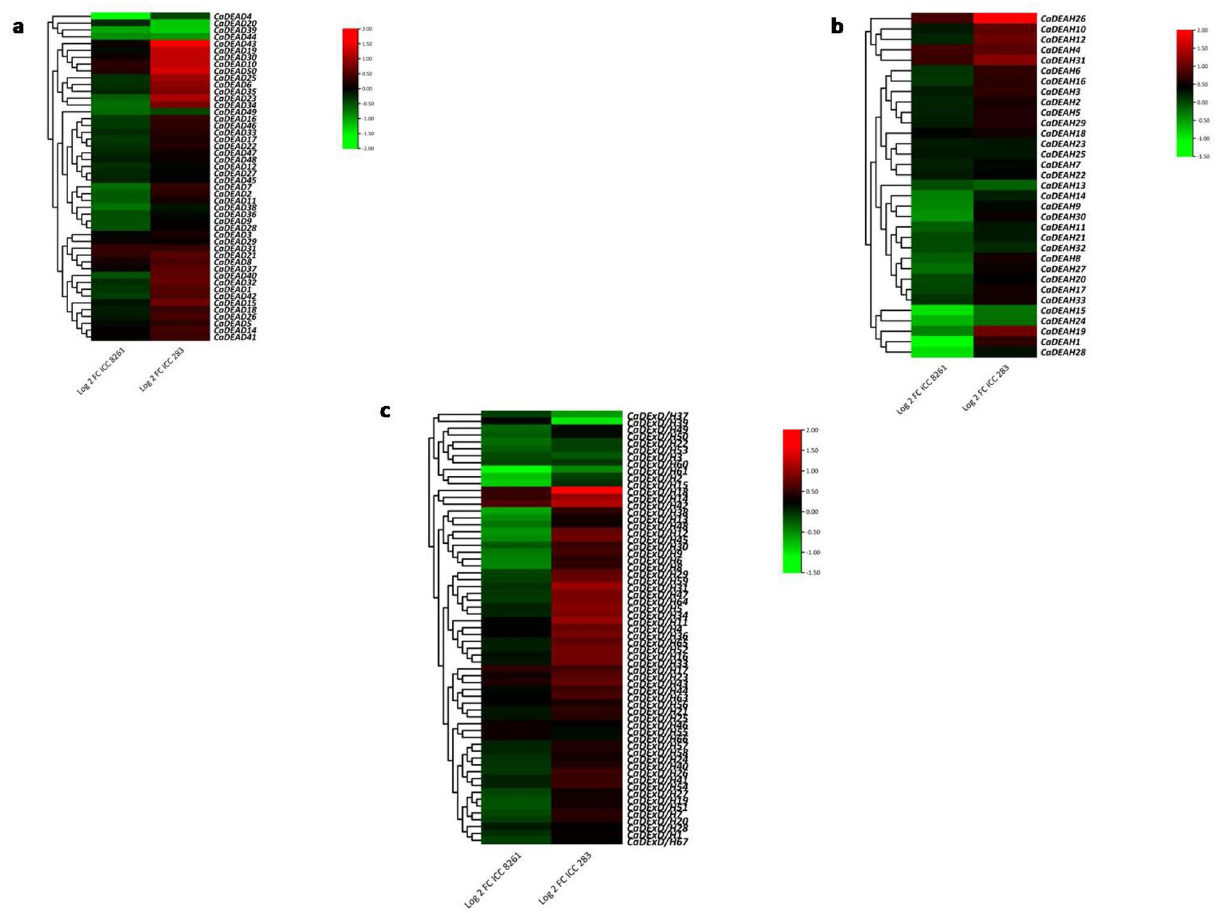
Figure 9. The heatmaps depicting the log2 FC for the gene expression levels of the CaDEAD ( a ) , CaDEAH ( b ) and CaDExD/H- box ( c ) genes in response to drought stress conditions. These values were obtained from the publicly available transcriptome data for the leaf tissues of two genotypes contrasting for drought stress tolerance; ICC 8261 (drought tolerant) and ICC 283 (drought sensitive). The heatmaps were generated using TBtools Version 1.098693 (https:// github. com/ CJ- Chen/ TBtoo ls/ relea ses).